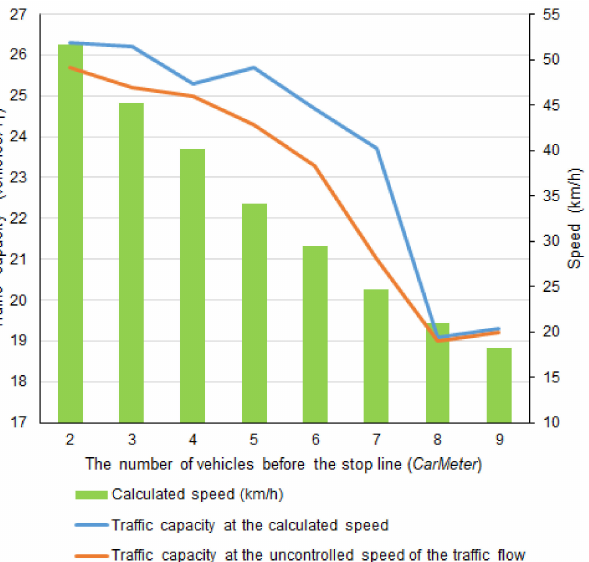
Figure 7. The number of vehicles that passed the intersection at the calculated and uncontrolled speed ( S 1 = 120